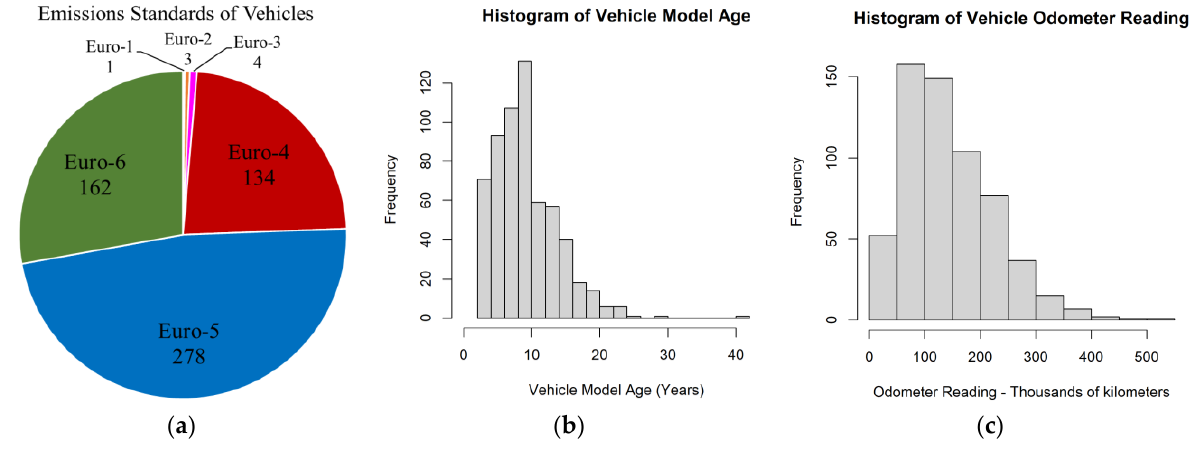
Figure 1. Fleet characteristics: ( a ) pie chart of vehicle emission standards (24 vehicles had pre-Euro or unknown Euro standard so are not represented here); ( b ) histogram of fleet model ages; ( c ) histogram of fleet odometer readings. Table 1. Evolution of the enhanced PTI protocol over the course of the